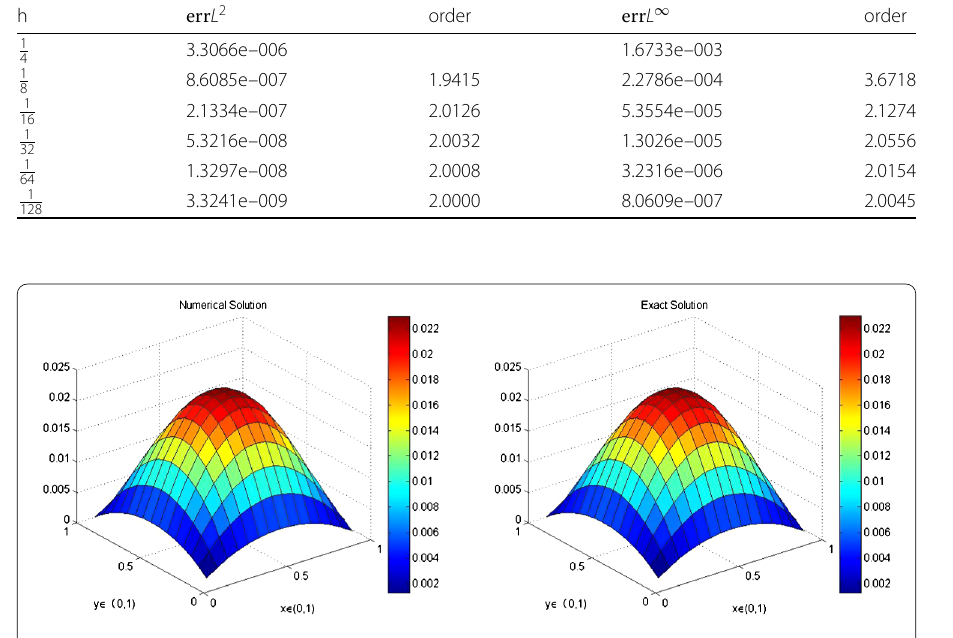
Figure 6 The effect of numerical solution and exact solution at fixed T = 1, h = 1 ( a ) N = 2 4 . ( b ) N = 2